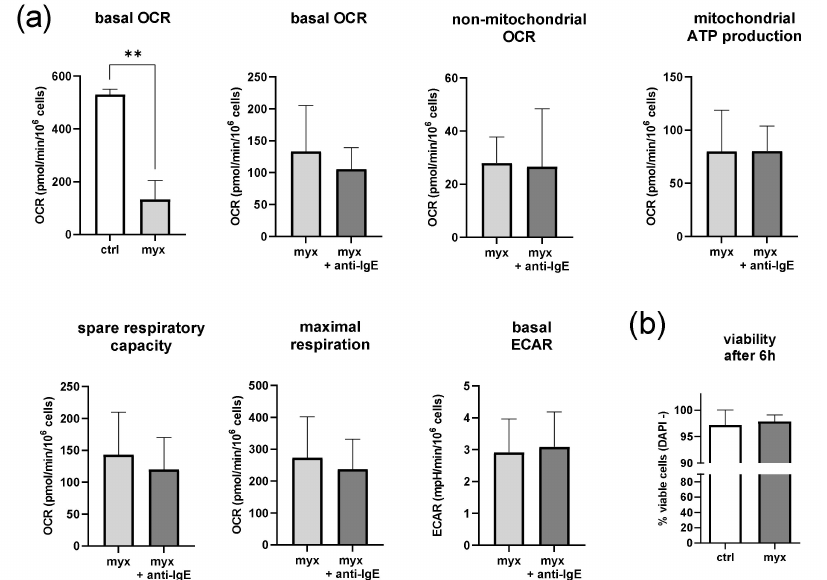
Figure 3. Inhibition of complex III of the respiratory chain reduces mitochondrial parameters and extracellular acidification, but not the viability of human skin MCs irrespective of IgE-mediated activation. ( a ) Inhibition of complex III of the respiratory chain in the human skin MCs using myxothiazol (myx) under glucose-free conditions reduced the mitochondrial parameters and ex- tracellular acidification rate (ECAR). It blocked an increase in the oxygen consumption rate (OCR) after IgE-mediated activation. ( b ) Human skin MC survive (DAPI -) substantial metabolic restriction.